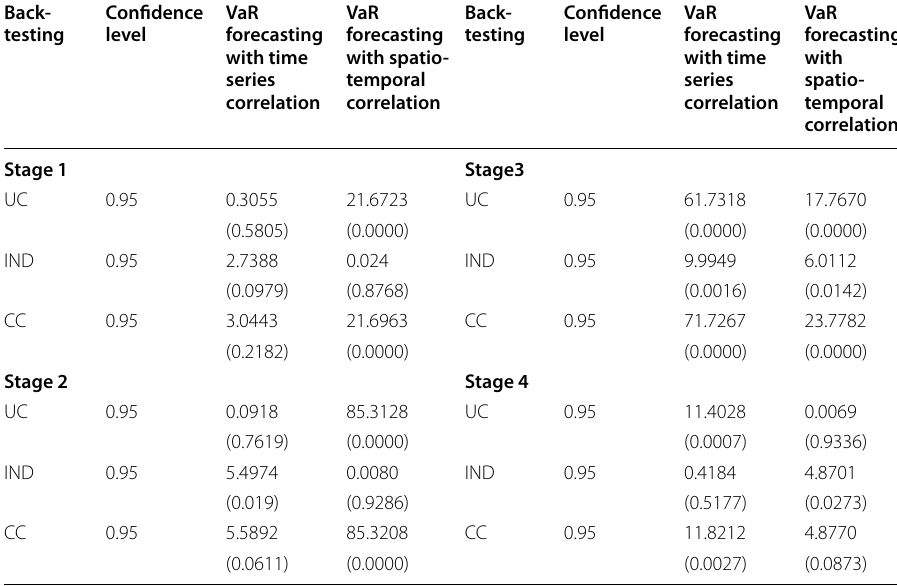
Table 6 VaR forecasting results based on the two correlations (Christoffersen test (Christoffersen,